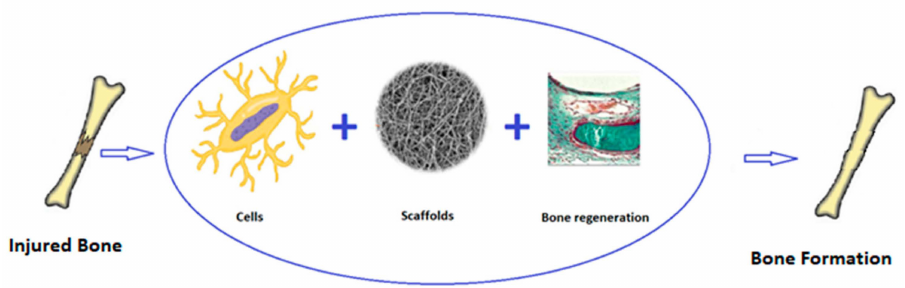
Figure 4. A flow chart illustrating the bone regeneration process